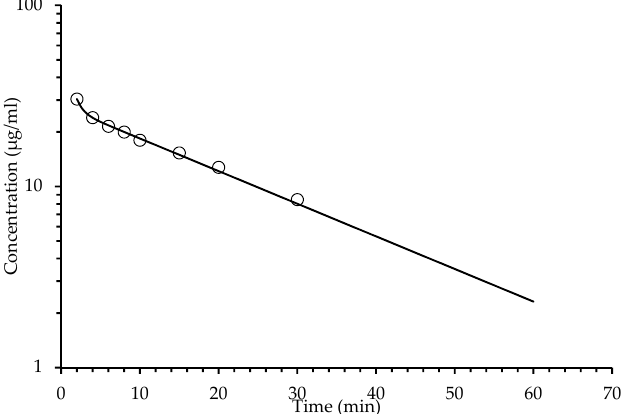
Figure 4. Analysis of variation of the tomentin and scopoletin (coumarin mixture) concentration in plasma with respect to time, after oral administration (400 mg/kg) of the SaTSS standardized fraction. The line represents the prediction of the behavior of the concentration following a two-compartment model.